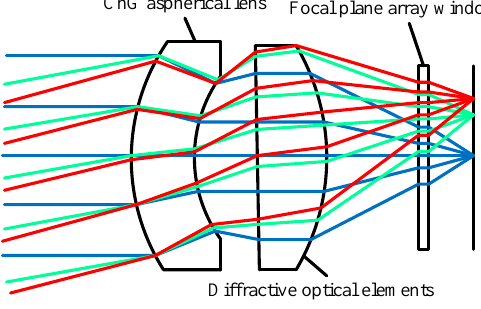
Figure 3. The optical layout of ChG aspherical lens.